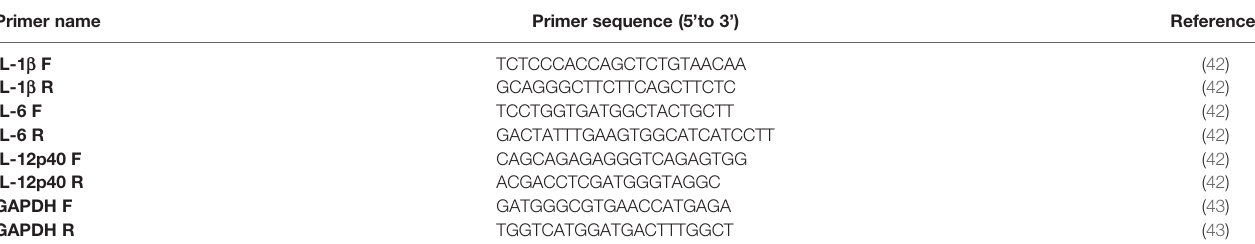
TABLE 1 | RT-qPCR